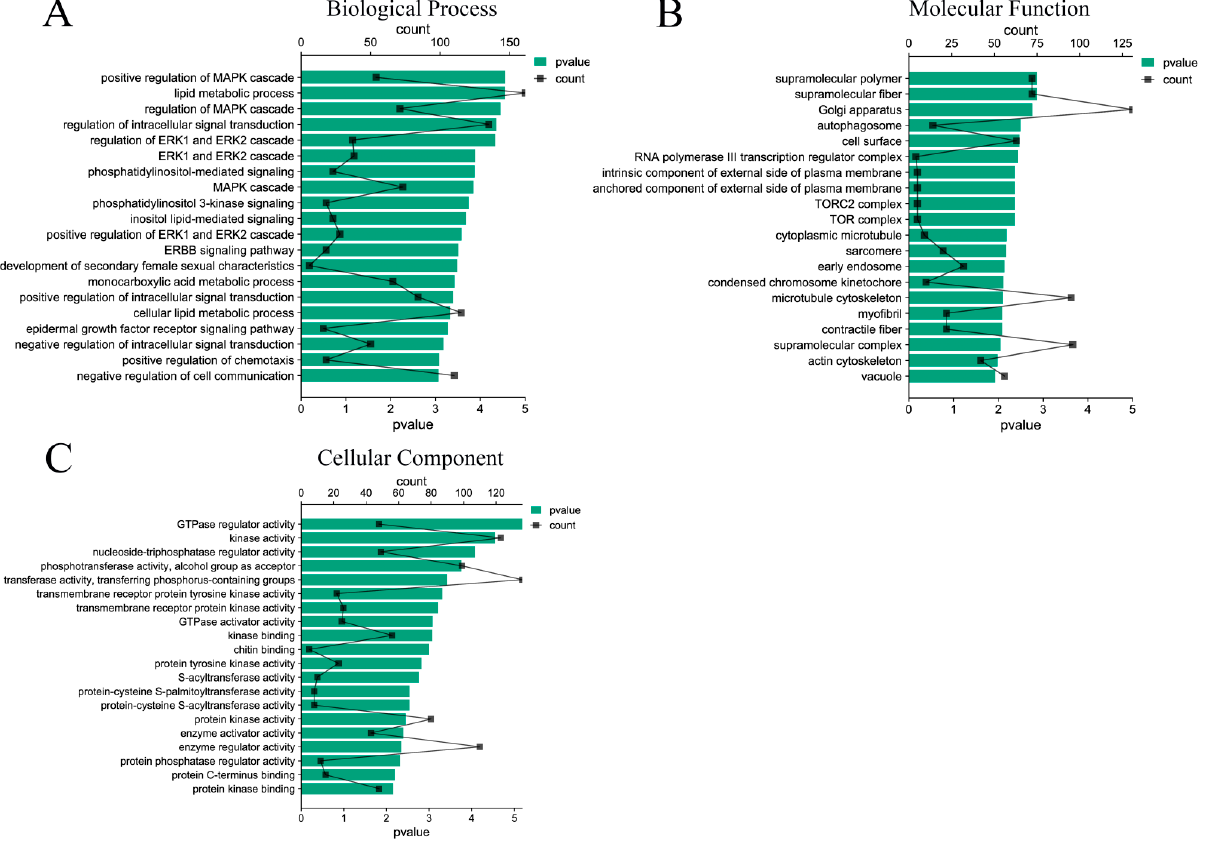
Figure 4. GO function enrichment analysis of DE miRNAs target genes. ( A ) Biological process of DE miRNAs target genes; ( B ) molecular functions of DE miRNAs target genes; ( C ) cellular components of DE miRNAs target genes.